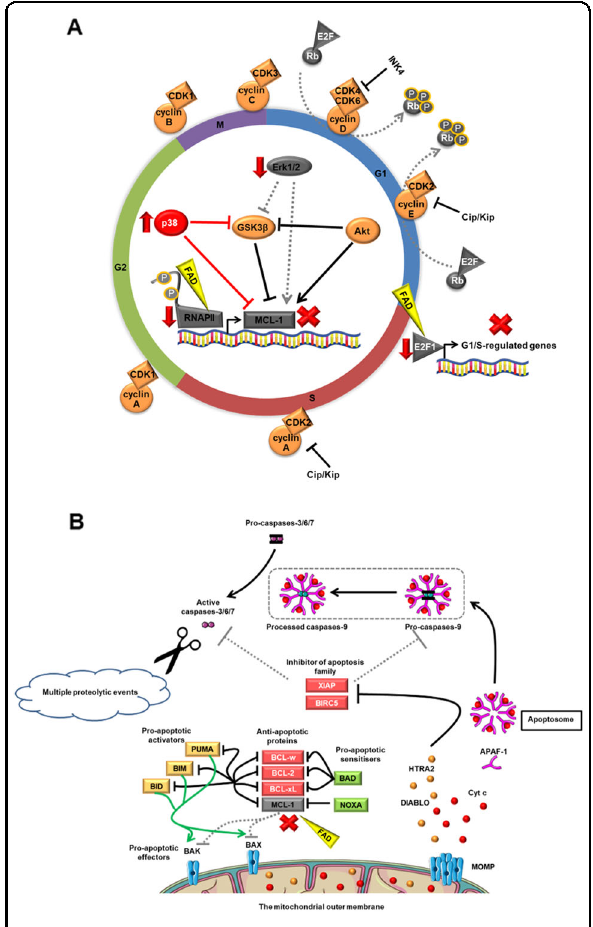
(Table. 1). We therefore observed a more variable fadra- ciclib response with KMT2A -PTD status not being a predictor for better treatment response. This is consistent with previous results showing that the CDK9-speci fi c inhibitor atuveciclib inhibits the proliferation of seven AML cell lines, regardless of KMT2A -r status 64 . In addi- tion, atuveciclib displayed potent in vitro activity in 80% of AML patient samples harboring KMT2A WT, includ-